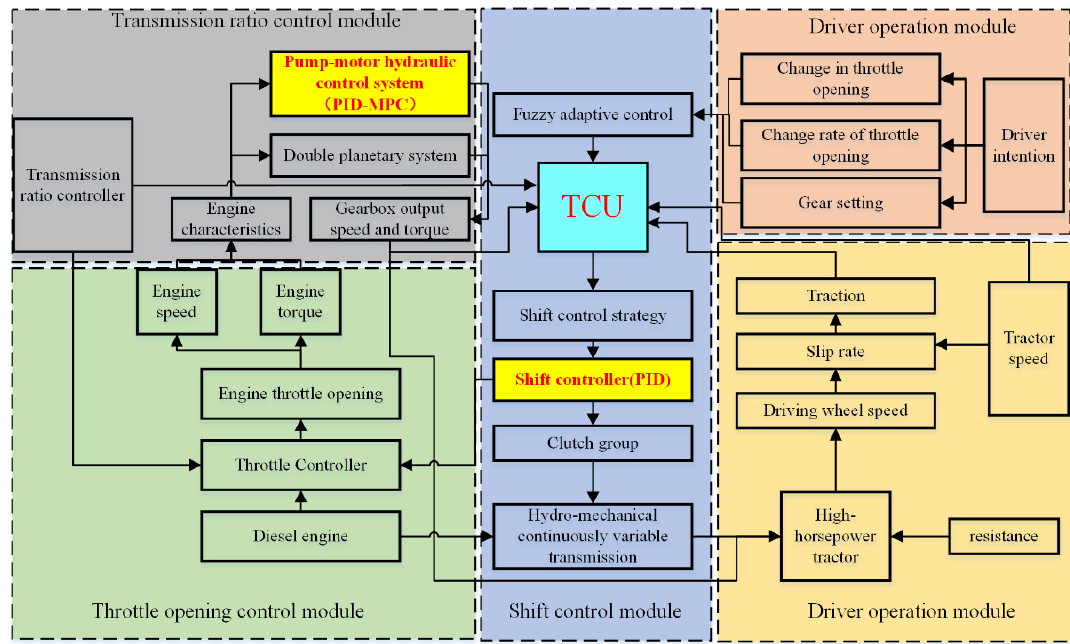
Figure 8. HMCVT shift control strategy.